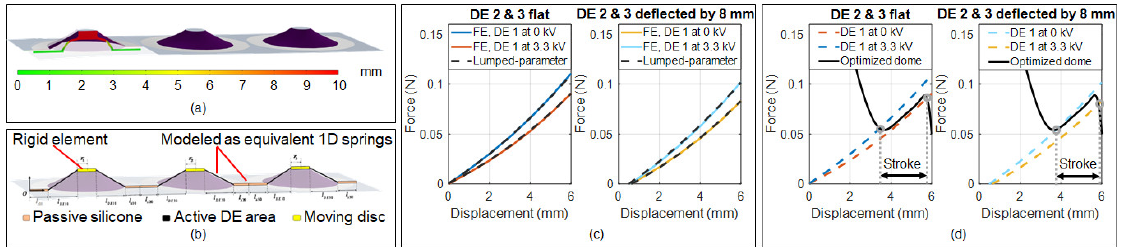
Figure 6. 3 × 1 DEA system, lumped-parameter model for computational efficiency ( a , b ), electro- mechanical simulation of 3 × 1 DEA system, experimental validation actuation ( c , d ).